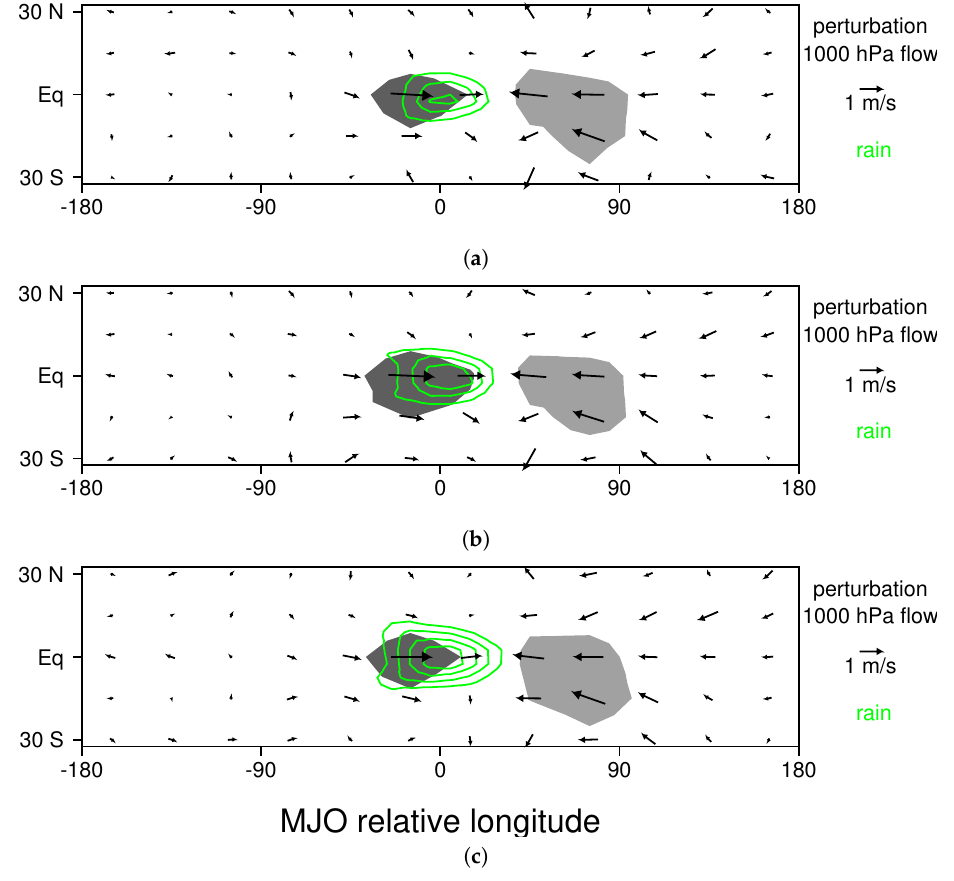
Figure 7. MJO perturbation 1000 hPa flow in MJO relative coordinates for the mature stage of the MJO: ( a ) the control simulation; ( b ) the 3 K warming experiment; and ( c ) the 7 K warming run. Regions where westerly (easterly) wind components exceed 1 m/s in amplitude are shaded dark (light) gray. Perturbation rainfall is contoured in green for 3, 5, 7, and 9